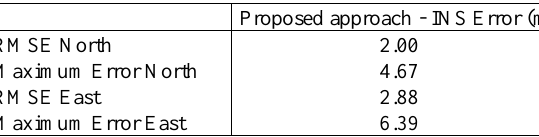
Table 4. Proposed approach performance errors during 120 Secs of GNSS signal outage.